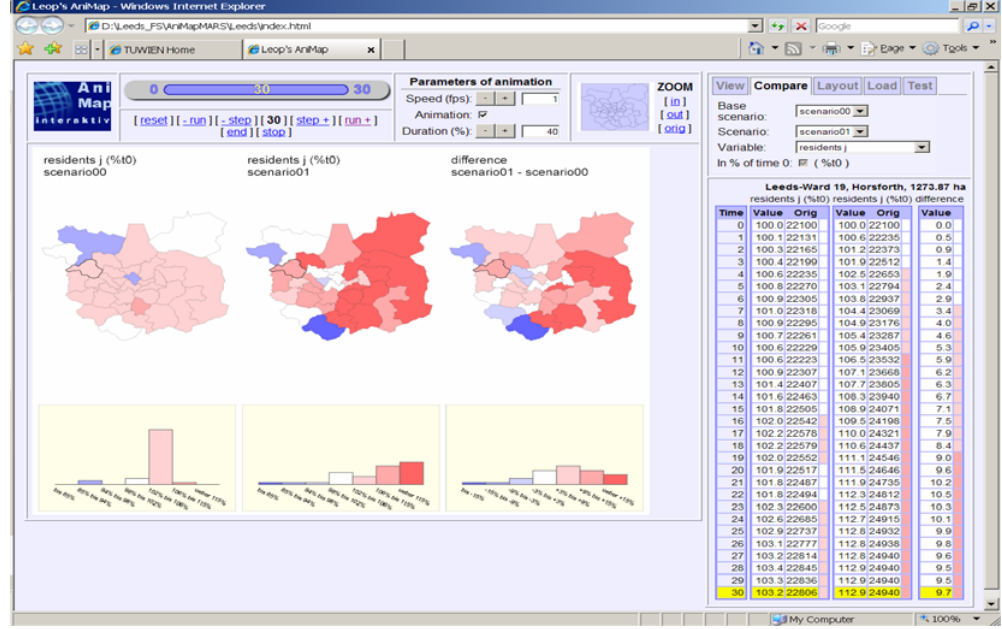
Figure 14. Screen shot from MARS-Animap animation